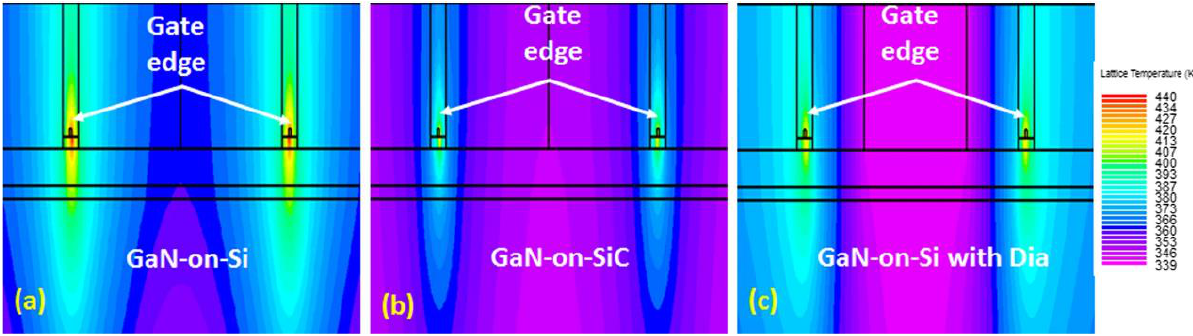
Table 2. Simulated electrical behavior of different AlGaN/GaN HEMTs [36].